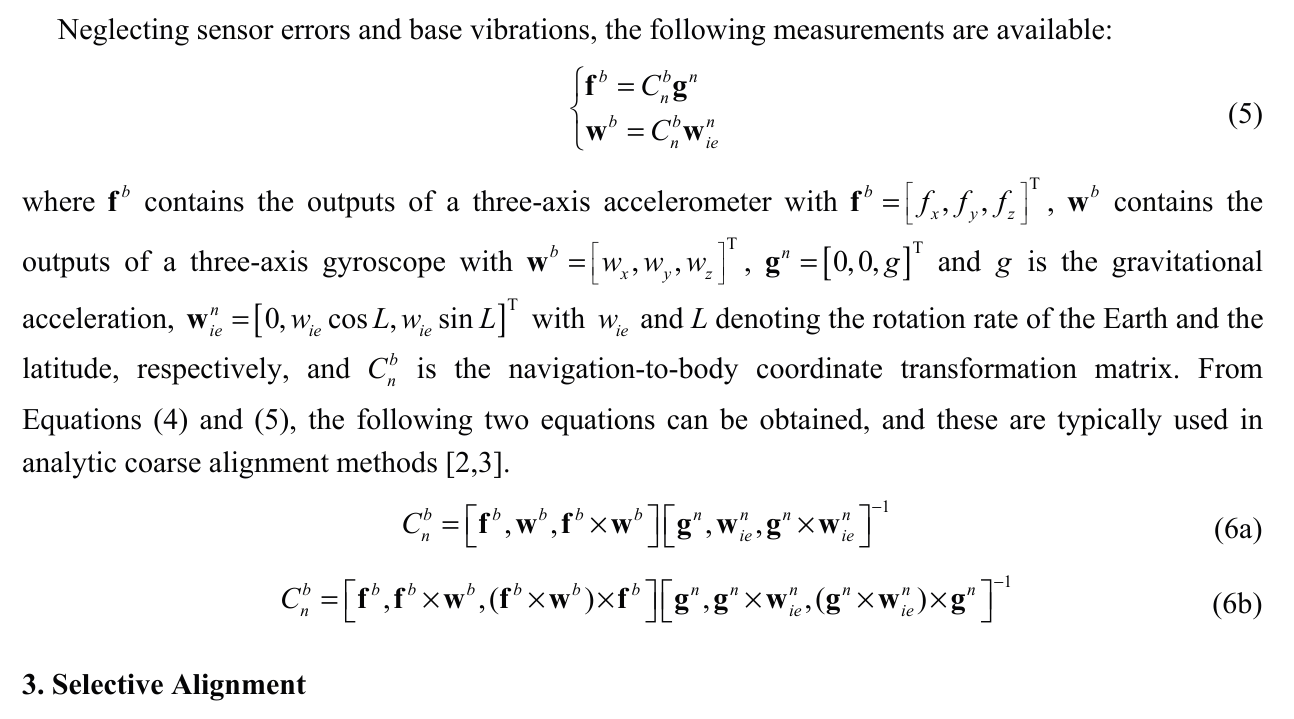
Figure 1. The gravity and rotational velocity vectors in the navigation